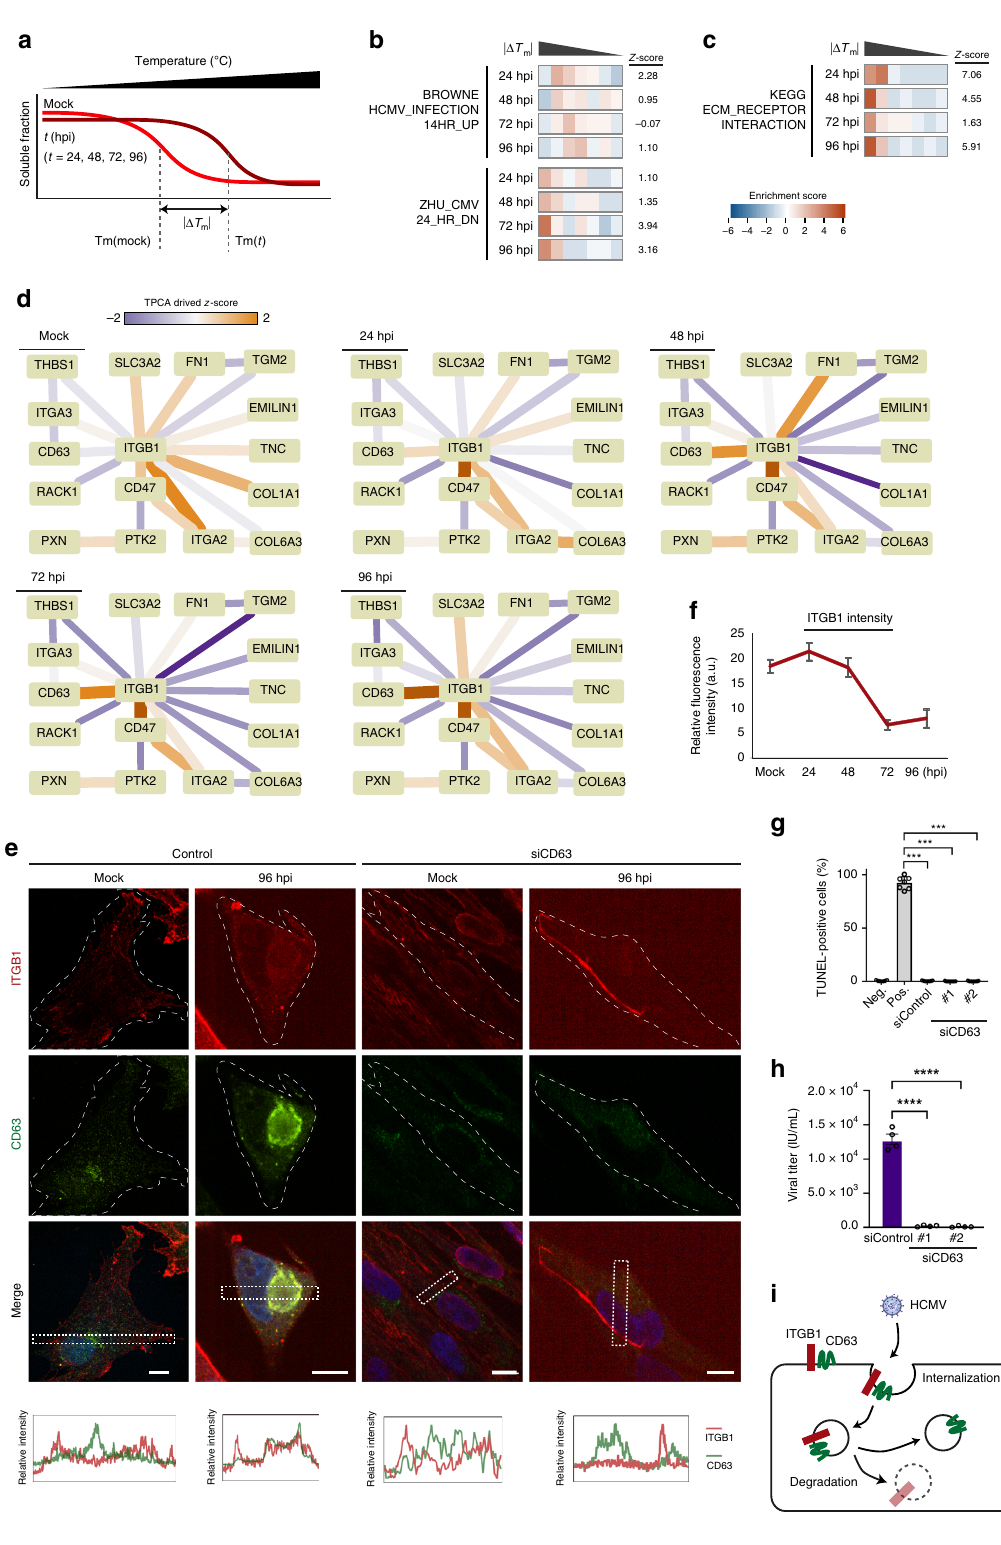
is in part mediated via association with CD63, with CD63 exhi- biting a pro-viral function (Fig. 4i). Although our analysis based on | Δ Tm| captured numerous